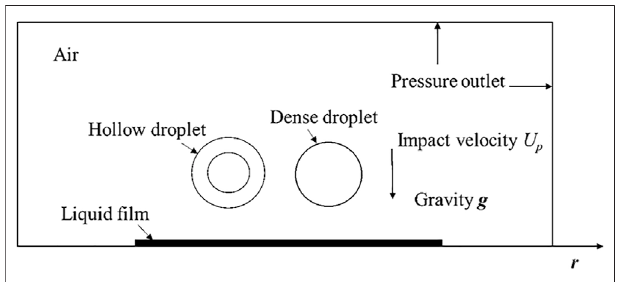
FIGURE 1 | Computational domain and boundary